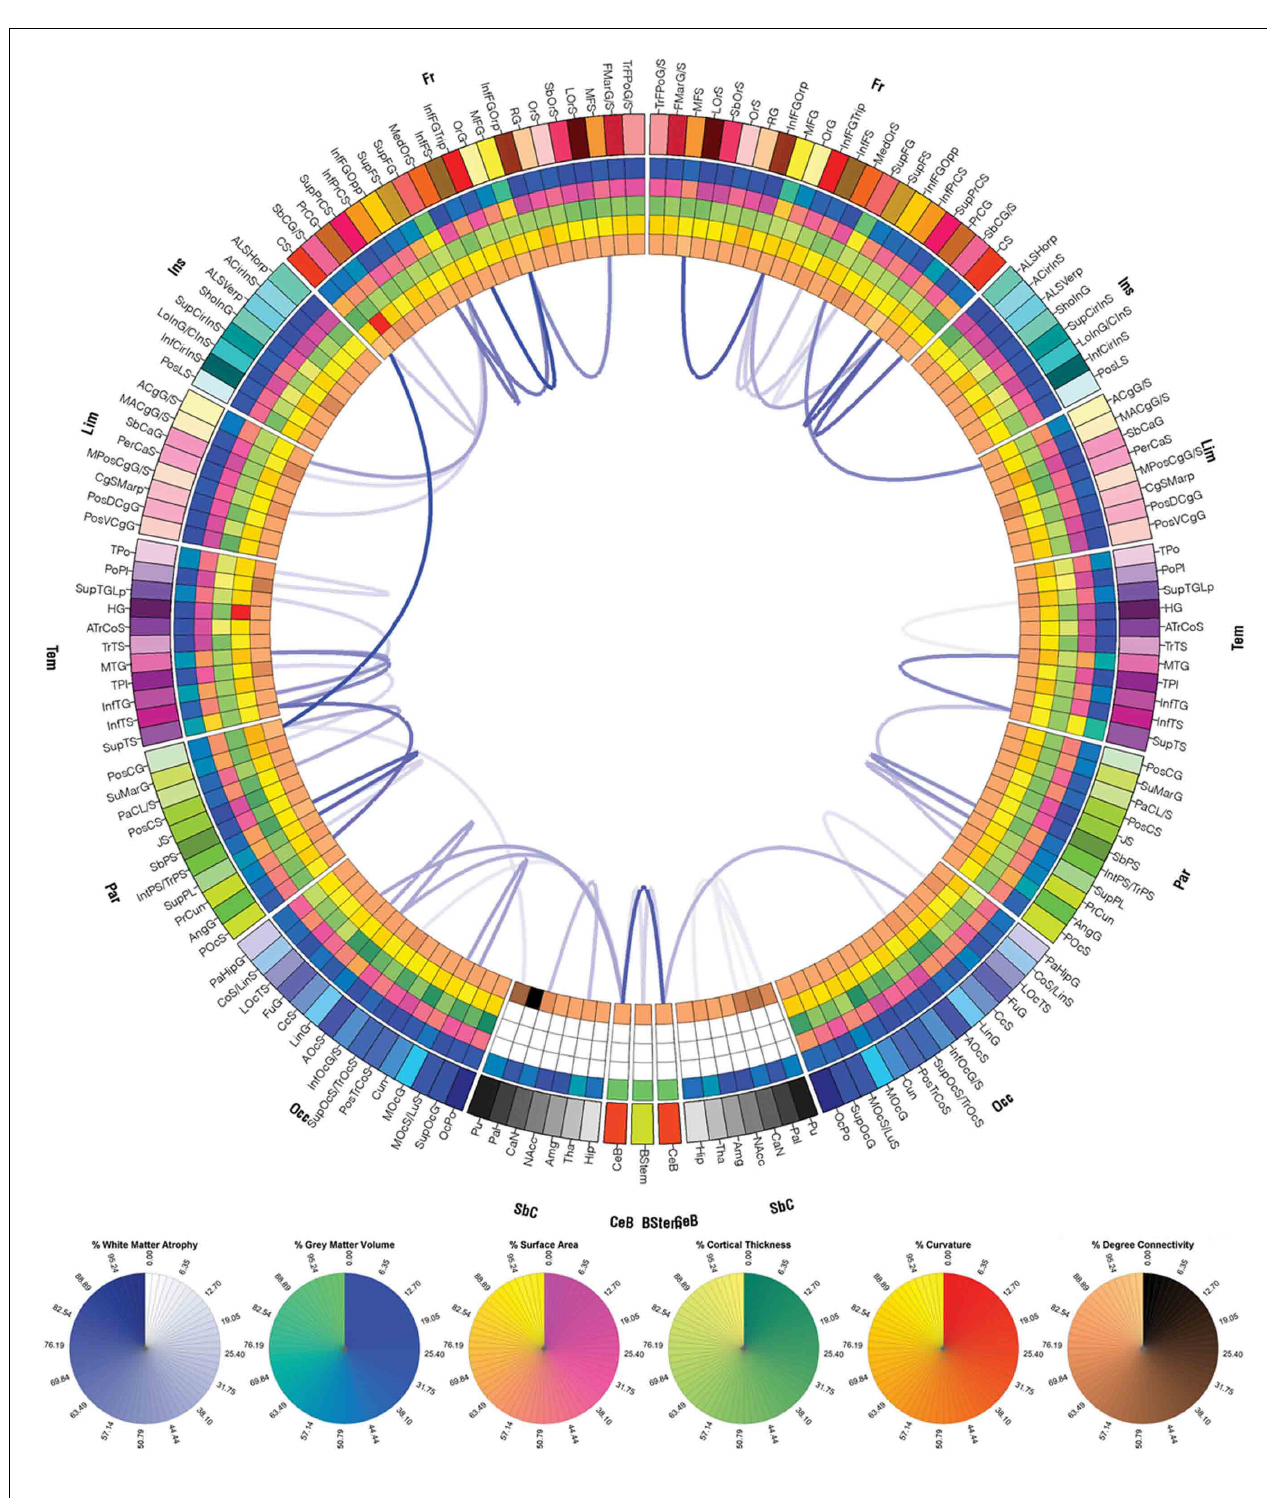
being encoded by more opaque hues of blue.The lowest color opacity corresponds to the smallest absolute value of the percentage change that is greater than the chosen threshold of 20%, and the highest opacity corresponds to the maximum absolute value of the change in fiber